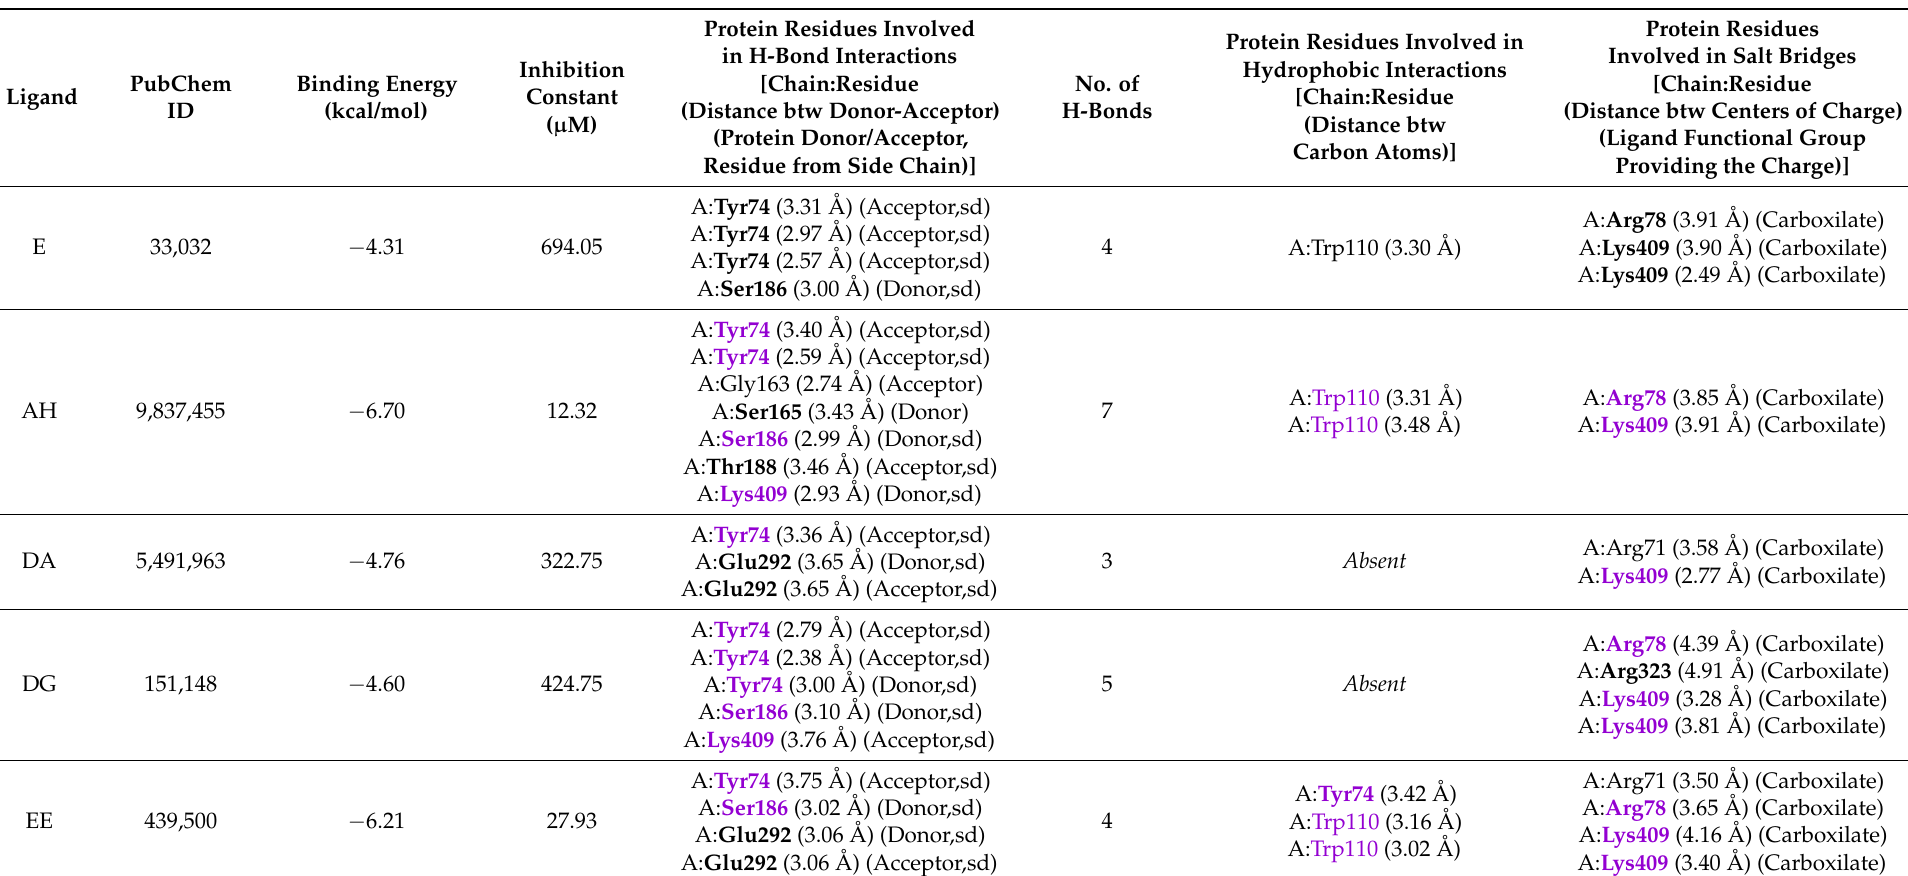
Table 3. Rattus norvegicus open–open conformation (PDB ID: 1EWT) of mGluR1 residues involved in docking interactions with glutamic acid and the umami dry-cured ham dipeptides of this study, with docking